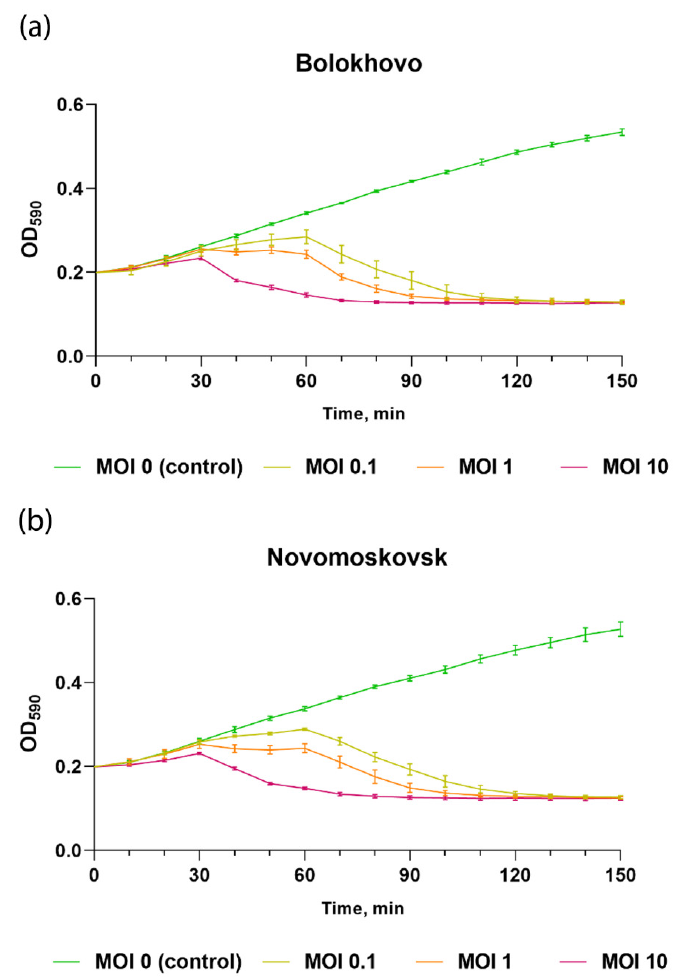
Figure 5. Time-kill assay of Bolokhovo and Novomoskovsk phages. B. pumilus AVS-01 growth kinetics upon infection with ( a ) Bolokhovo and ( b ) Novomoskovsk at different MOI. The error bars represent the standard deviation from the means of the three independent trials.